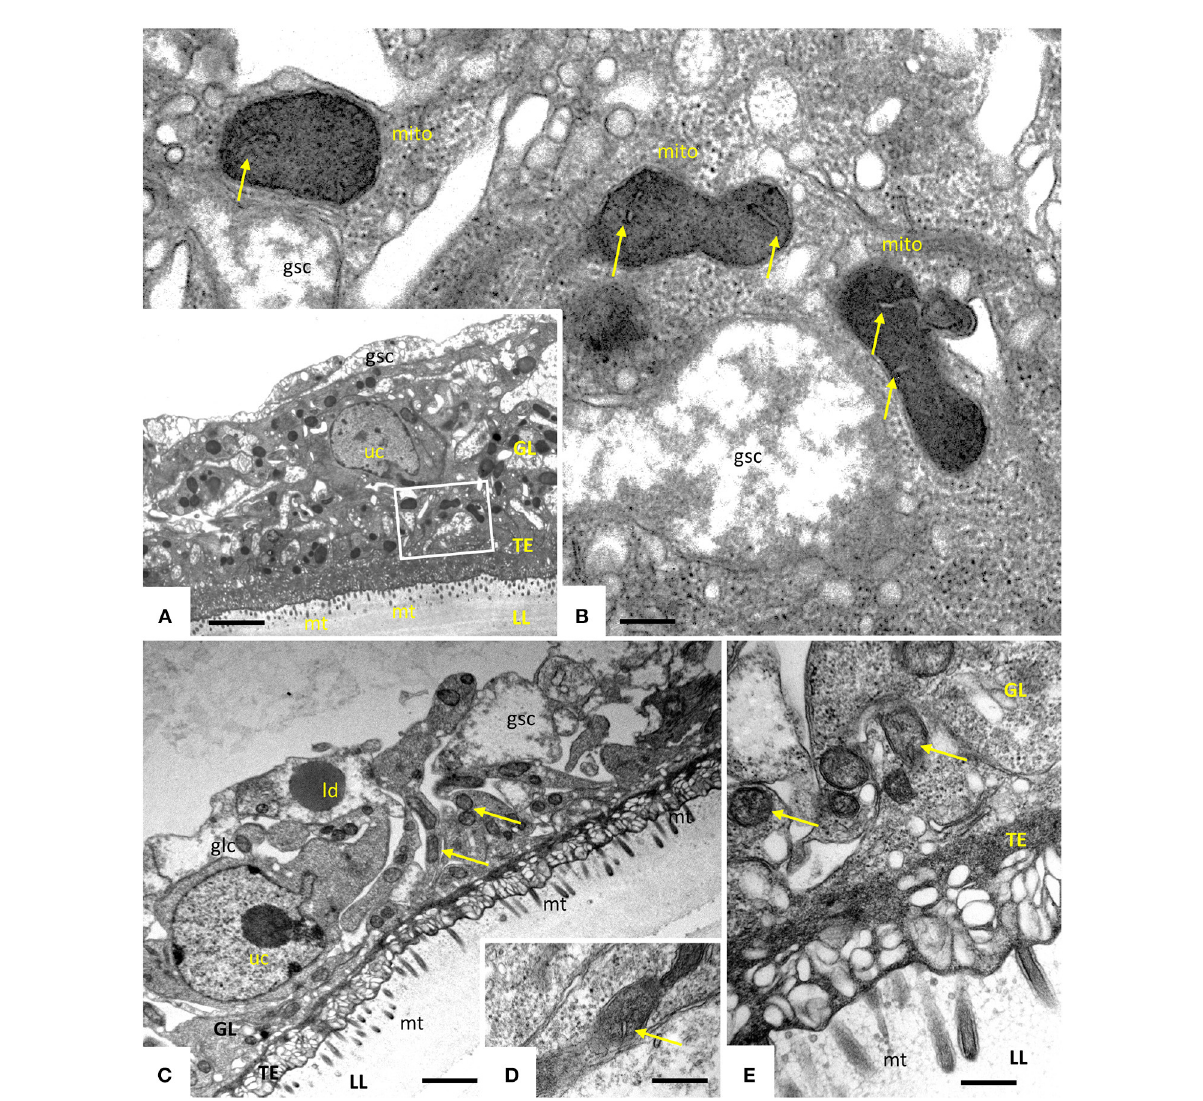
FIGURE2 Transmission electron microscopy (TEM) of E. multilocularis metacestodes treated with 0.2 µ M ELQ-400. TEM of non-treated metacestodes (A,B) and metacestodes treated with 0.2 µ M ELQ-400 (C,D) under normoxic (21% O 2 ) conditions. The boxed area in (A) is shown at higher magnification in (B) . Parasites are comprised of an outer laminated layer (LL), a tegument (TE) with numerous microtriches (mt) protruding into the LL, and the GL comprised of various cell types, including glycogen storage cells (gsc) and undifferentiated cells (uc). Structures remain largely unaltered in the presence of 0.2 µ M ELQ-400 (C,D) . Note the presence of mitochrondria (mito) (B–D) with a rather electron-dense matrix and cristae (arrows); ld, lipid droplet. Bars in (A) = 2.4 µ m; (B) = 0.25 µ m; (C) = 1.2 µ m; (D,E) = 0.40 µ